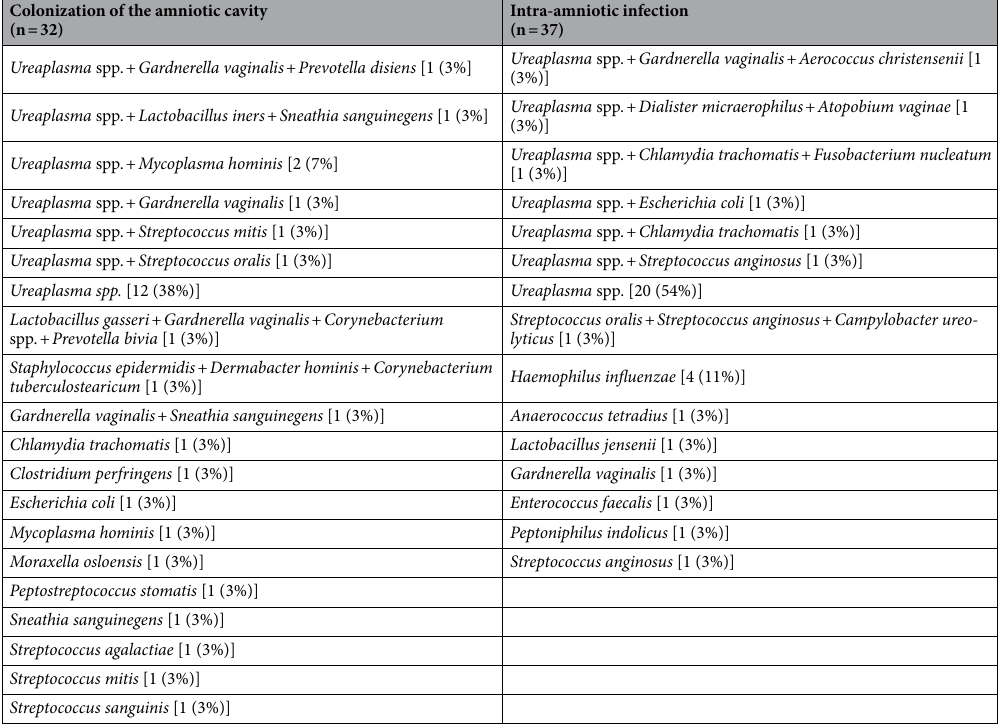
Table 3. The microbial species identified in the amniotic fluid of PPROM pregnancies with colonization of the amniotic cavity and intra-amniotic infection. Categorical data are presented as number (%).